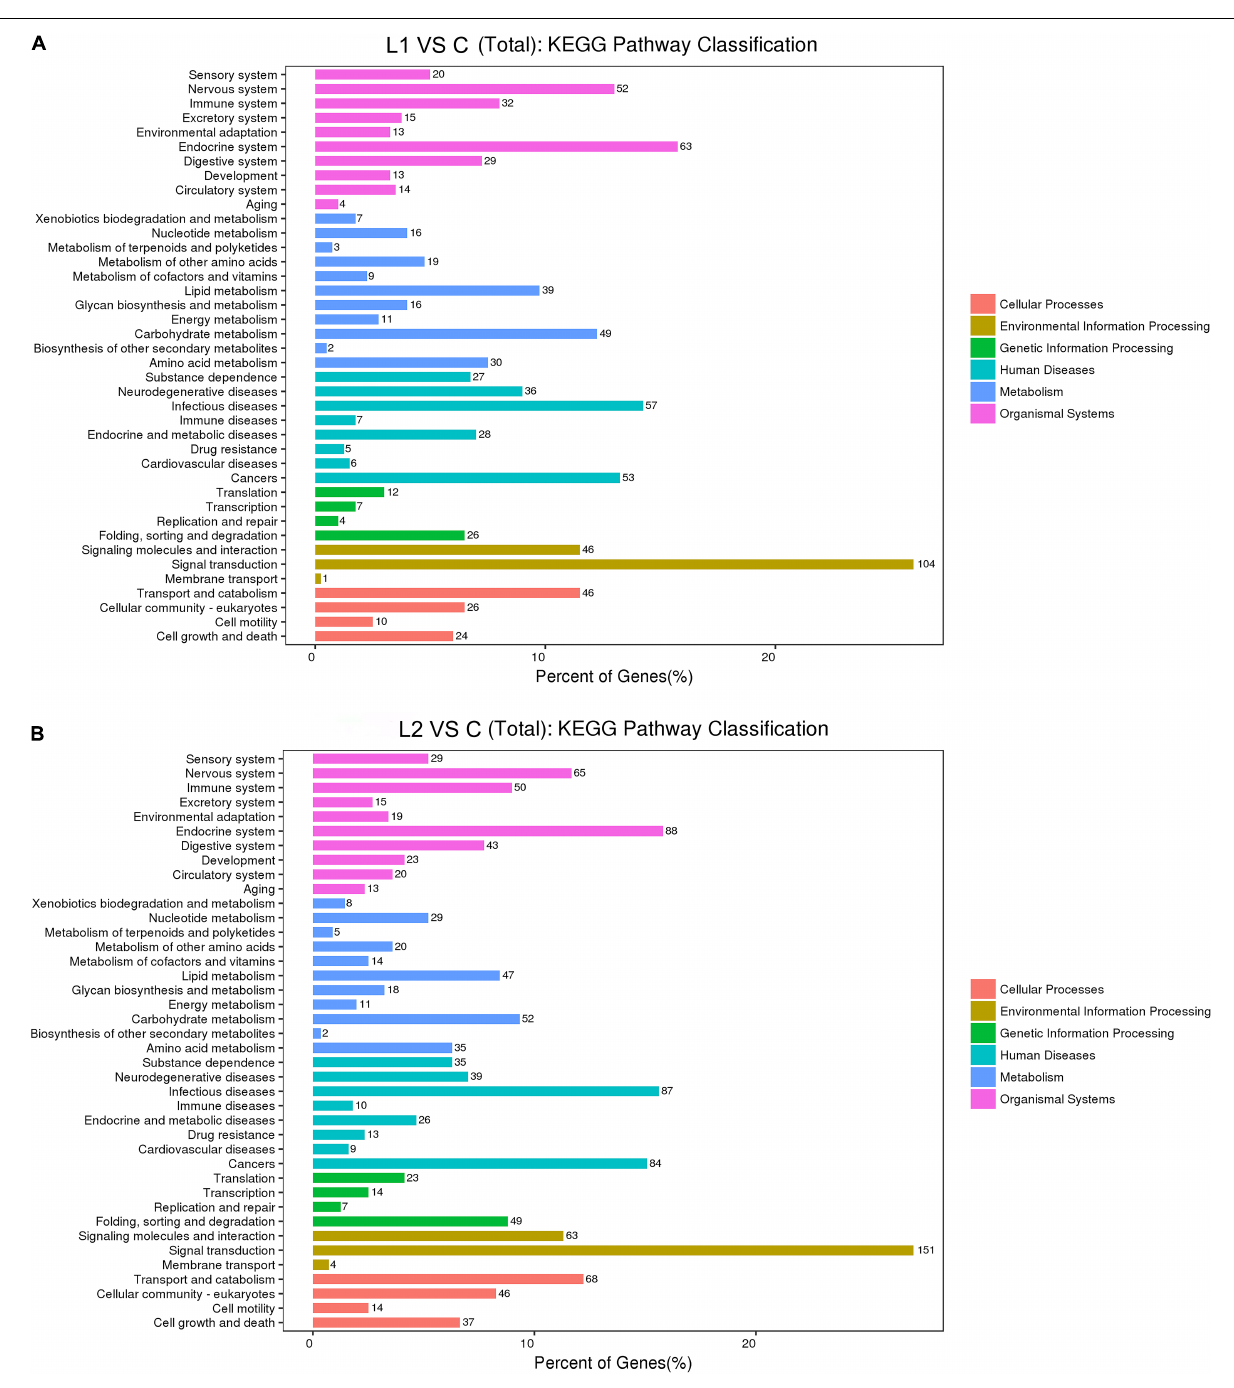
results showed that the findings obtained by qRT-PCR were consistent with the RNA-seq data, which confirmed the reliability of the RNA-seq